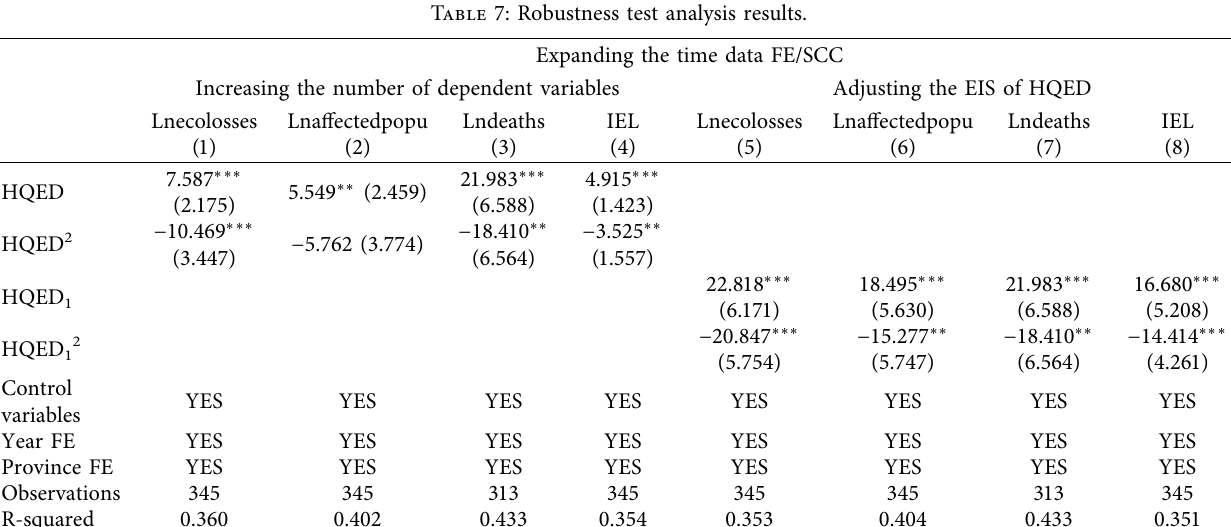
Table 7: Robustness test analysis results.